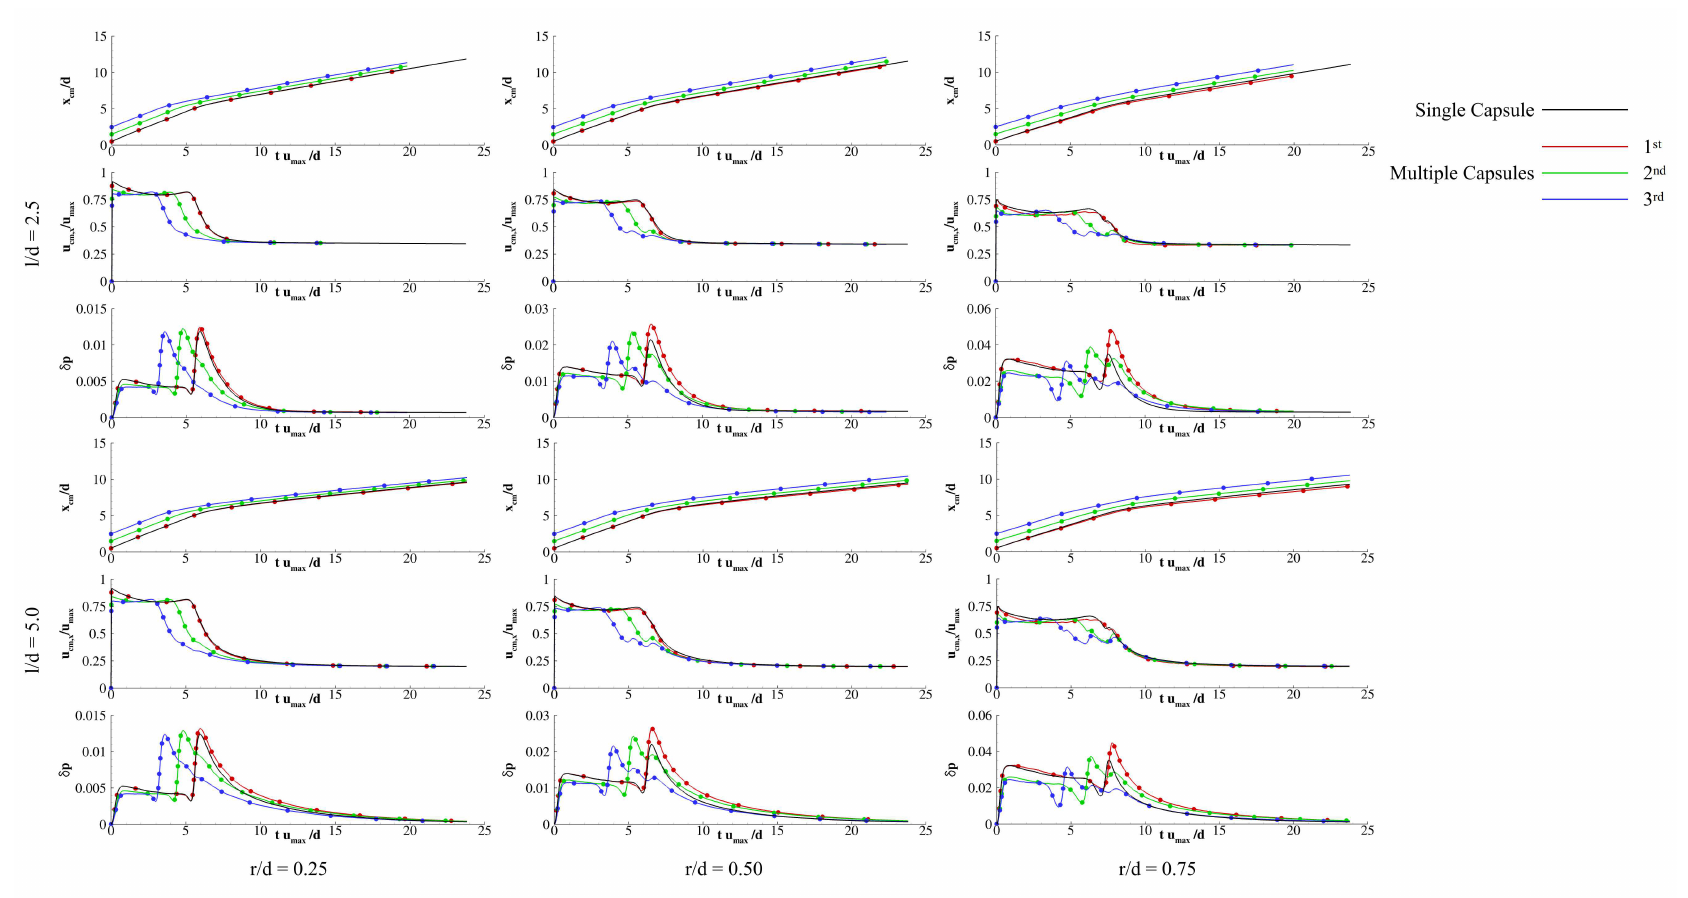
Figure 6. Transport of three aligned capsules in the micro-channel, for capsule diameter to channel ratio: left column ( r / d = 0.25); middle column ( r / d = 0.50); right column ( r / d = 0.75). ( a ) distribution of the x -coordinate of the capsule centre of mass x cm over time for l / d = 2.5 ( top ) and l / d = 5.0 ( bottom ); ( b ) distribution of the x -velocity of the capsule centre of mass u cm , x over time for l / d = 2.5 ( top ) and l / d = 5.0 ( bottom ); ( c ) distribution of the capsule stretching computed as the relative − p 0 difference between the current, p , and the initial, p 0 , perimeter of the capsule ( δ p = p ) for l / d = 2.5 ( top ) and l / d = 5.0 ( bottom p 0